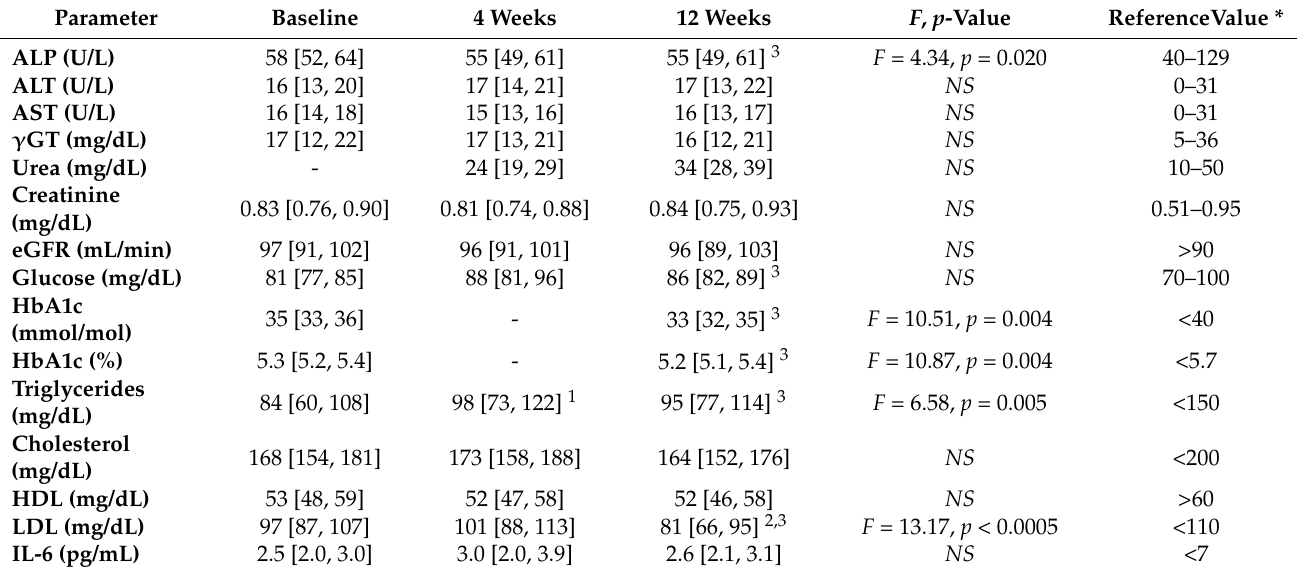
Pairwise comparisons among experimental times (4 weeks versus Baseline; 12 weeks versus 4 weeks; and 12 weeks versus Baseline): Waist circumference— 1 , p < 0.005; 3 , p < 0.0005. Table 3. Biochemical parameters of healthy volunteers for each experimental time. Mean [95% CI], n = 19.